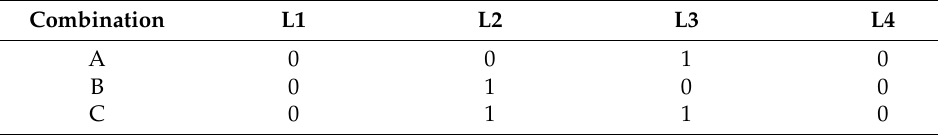
Table 3. Lateral combinations (“1”: Connected, “0”: Not connected).